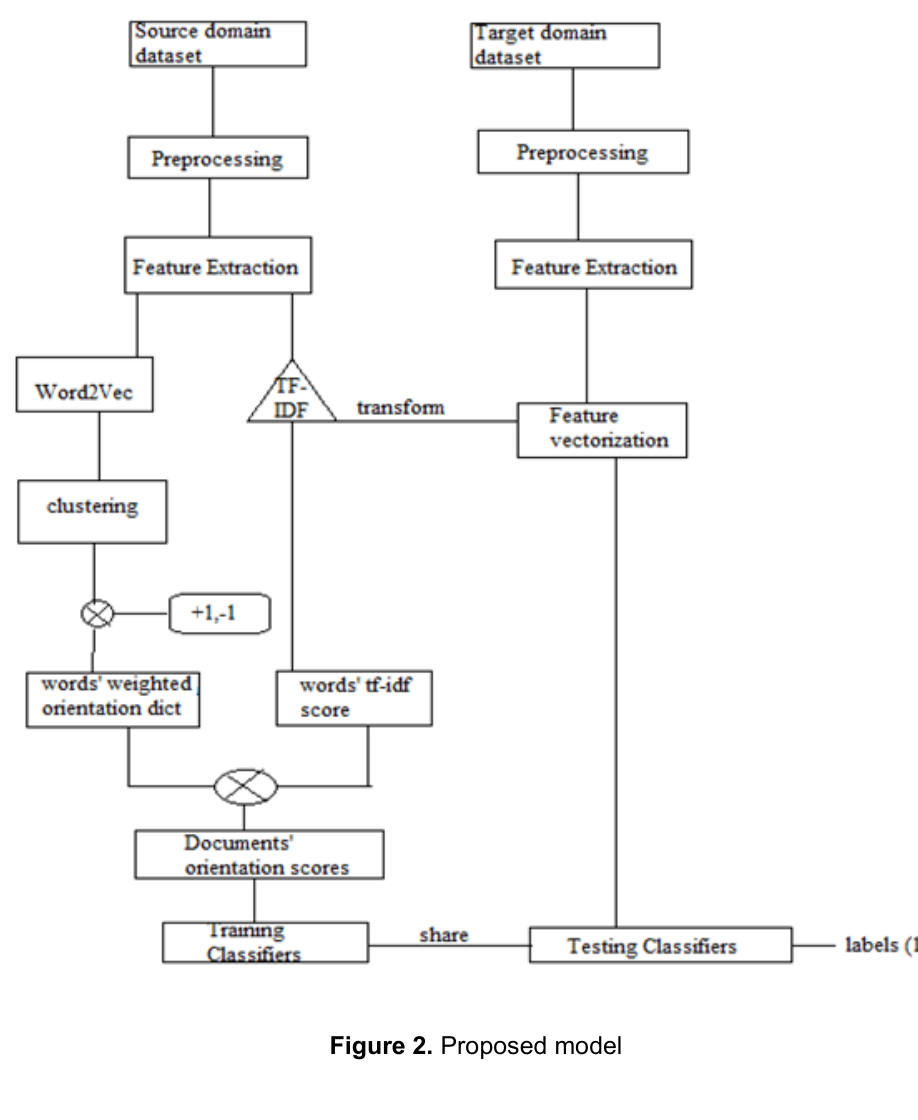
Figure 2. Proposed model